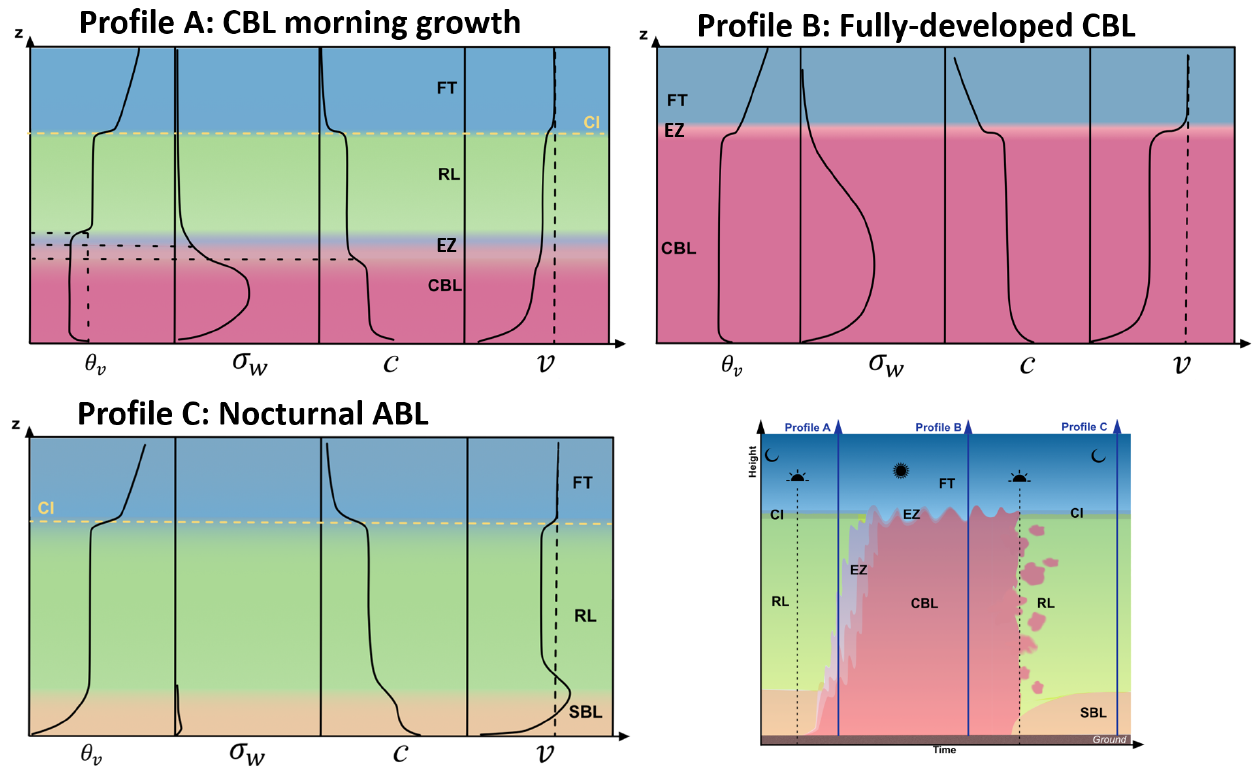
Figure 2. Idealised vertical profiles of exemplary atmospheric variables that are used to characterise thermodynamics (mean virtual potential temperature θ v ), dynamic and turbulent processes (vertical velocity variance σ w , mean horizontal wind speed v ), and resulting distributions of atmospheric tracers (mean atmospheric constituent c ) during the idealised diurnal evolution of the atmospheric boundary layer (ABL), which is illustrated in the time–height sketch for an ABL over flat terrain on a cloud-free day. Dashed vertical lines in the v panels represent the geostrophic wind reference. Selected profiles are shown at three distinct moments: Profile A, the morning growth of the convective boundary layer (CBL; pink shading); Profile B, early afternoon with a fully developed CBL; and Profile C, nocturnal conditions with a residual layer (RL; green shading) above the stable boundary layer (SBL; orange shading) near the surface. A capping inversion (CI) separates the ABL from the free troposphere (FT; blue shading) above. The entrainment zone (EZ) is a region of enhanced exchange between the CBL and the RL or FT, respectively. As the morning growth of the CBL (Profile A) is associated with high temporal variability of temperature, turbulence, and atmospheric constituents in the EZ, the temperature inversion, the reduction in vertical turbulent activity, and the vertical decrease in atmospheric constituent concentration may not always be located at the same height above ground, which is indicated by slightly changing colours and horizontal dashed lines. Idealised profiles and ABL sub-layer evolution adapted from De Wekker and Kossmann (2015), Beyrich (1997), and Stull